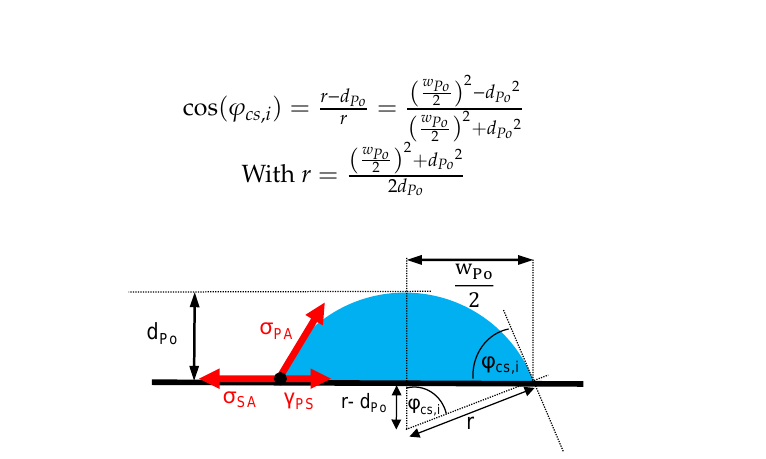
Figure 10. Schematic cross section of the polymer trace in the form of a cylinder segment.